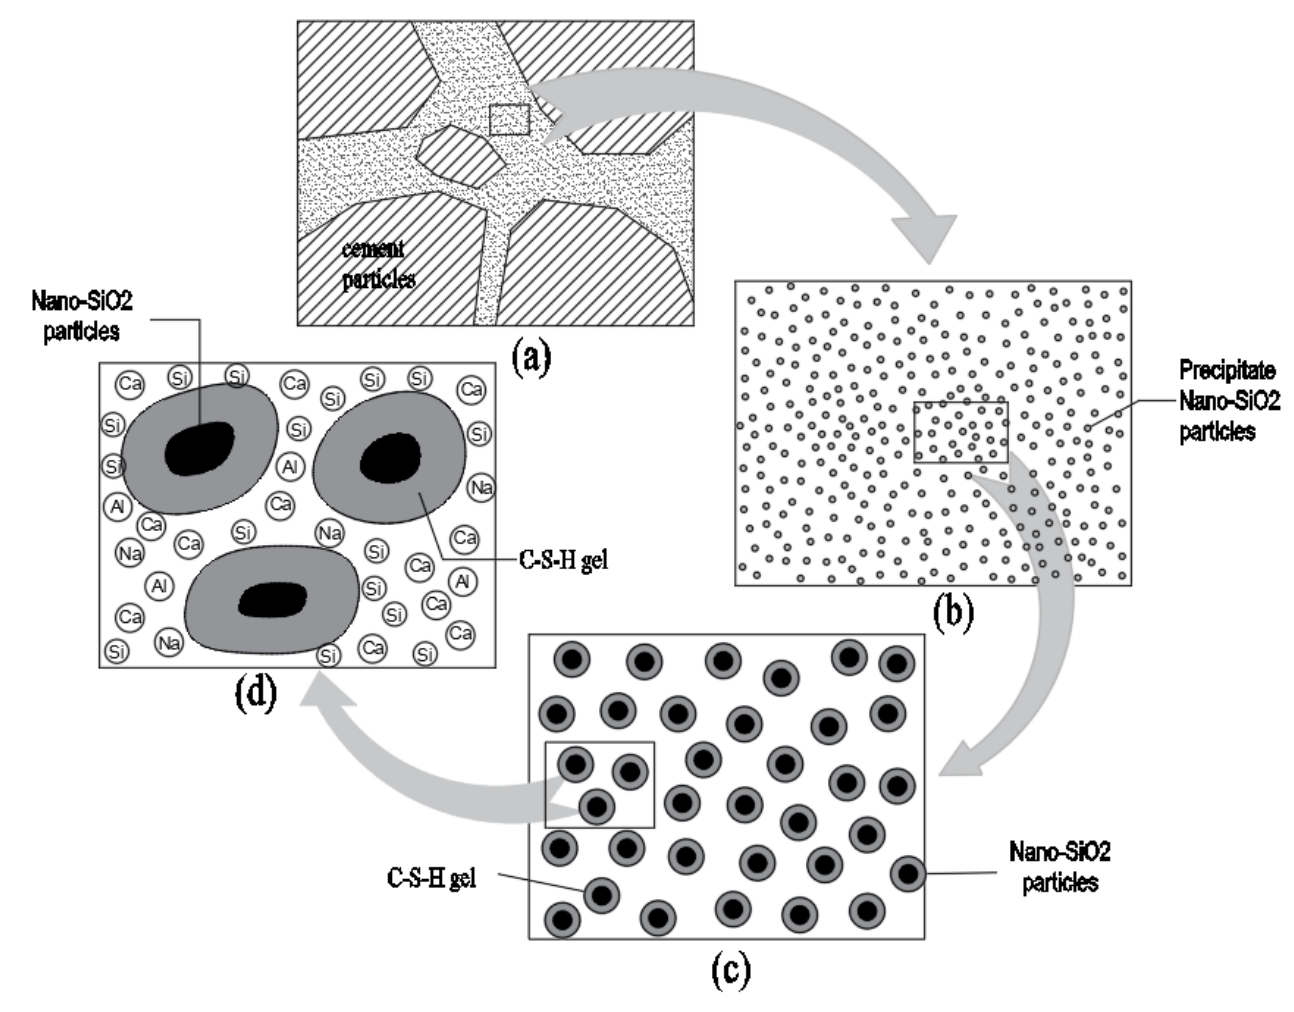
Figure 8. The microstructural reaction scale up model of PS-CBM.